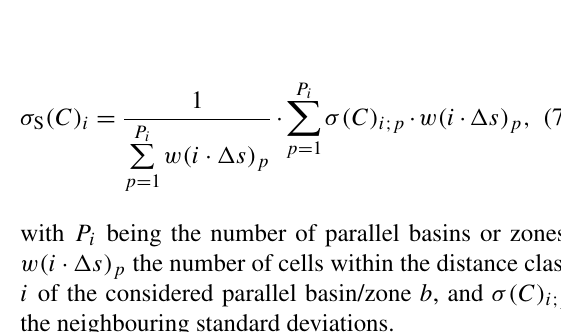
Figure 8. Sequence of the ACS